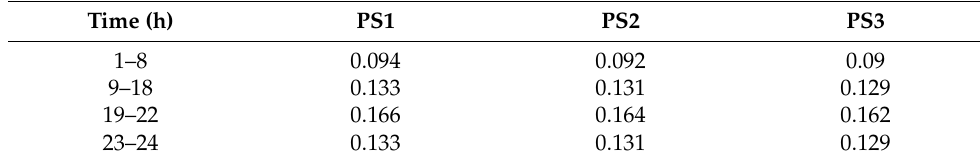
Table 3. Electricity for the case study ( €